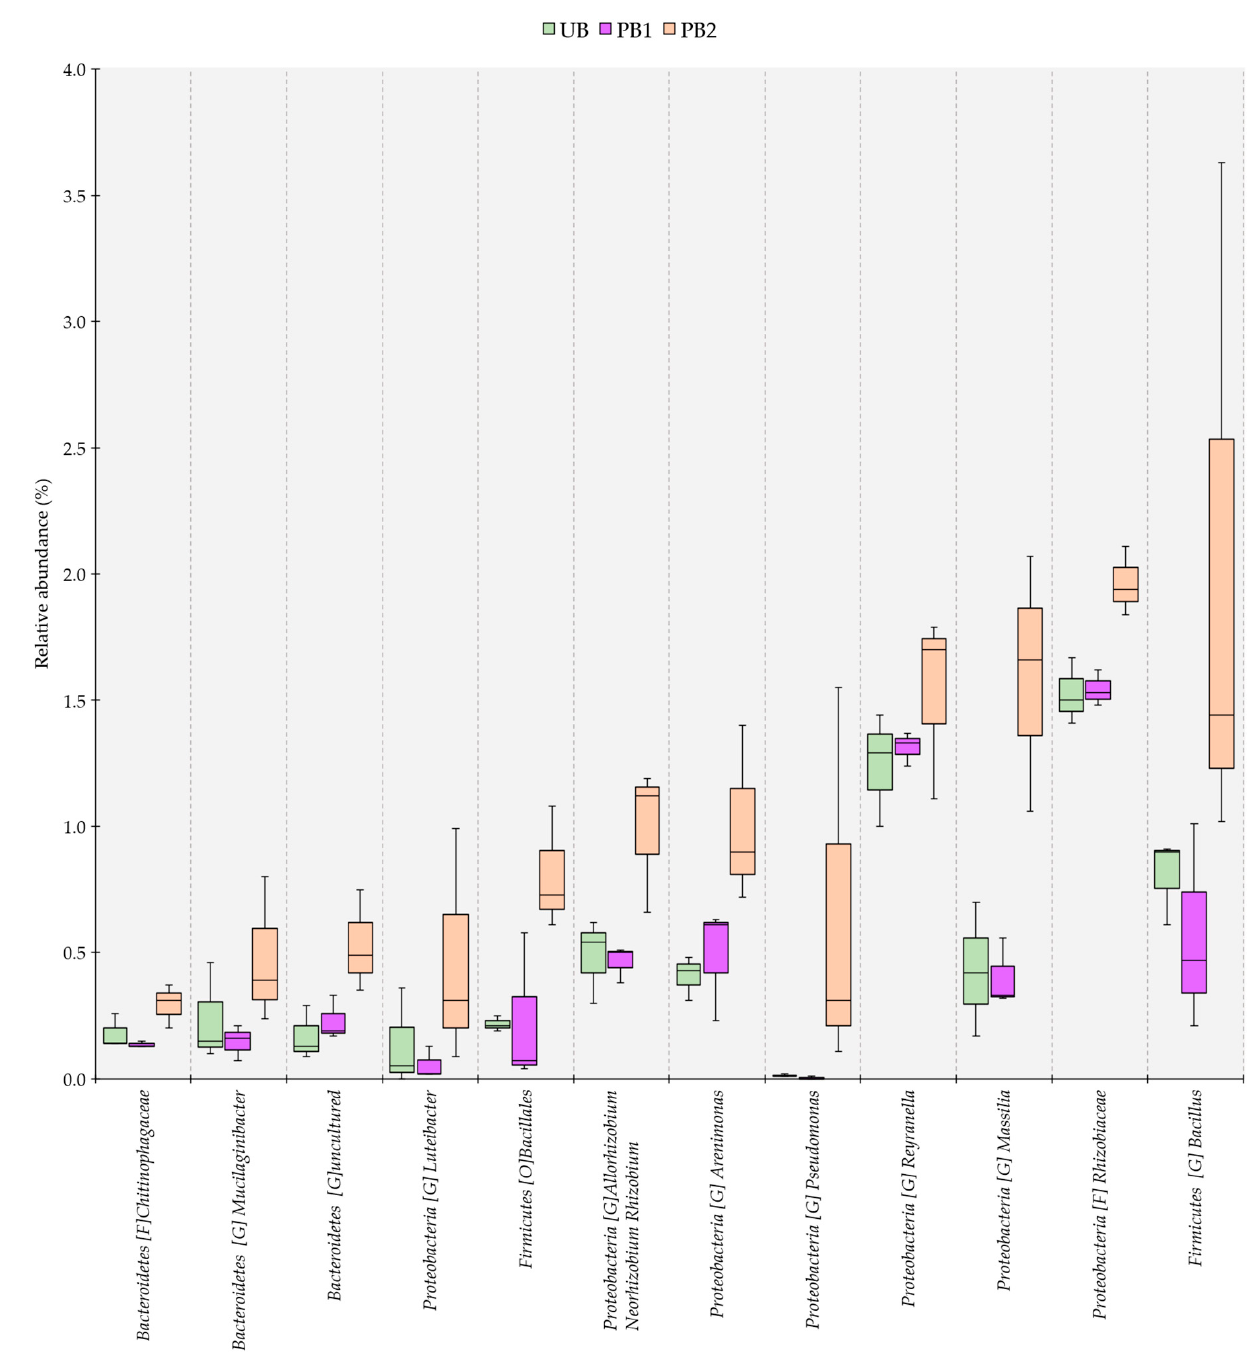
Figure 8. Bacterial taxa showing no difference with respect to UB at seven months after application of a prescribed burn (PB1). Increase in relative abundance (%) of bacteria after application of recent prescribed burning treatment (PB2) compared to UB. UB: control; PB1: soils treated with prescribed burning seven months before sample collection; PB2: soils treated with prescribed burning immediately prior to sample collection. Boxes include 50% of the data between the first and third quartiles (interquartile range) and the central line the median. The whiskers include those values that deviate from the first and third quartiles up to a maximum distance of 1.5 times the interquartile range. Values with a deviation greater than 1.5 times were represented as circles. Capital letters in square brackets indicate the lowest taxonomic level of classification: [O]: order, [C]: class, [F]: family, [G] genus.